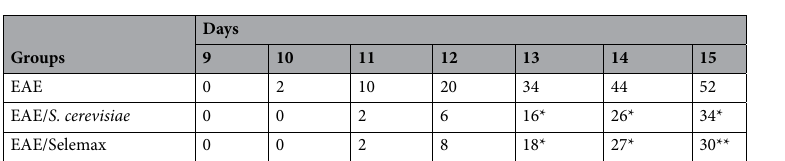
Figure 2. Effect of S. cerevisiae and Selemax on EAE development. EAE and non-EAE mice received 14 oral doses of S. cerevisiae or Selemax every day. The percentage of weight variation was calculated based on the initial and last animal´s body weight ( a ). Disease prevalence ( b ) and clinical score ( c ) were assessed daily for 15 days. Four independent experiments were combined, n = 6–8 in non-EAE groups and n = 16–21 mice in EAE groups. Inflammatory infiltration and demyelination were evaluated in hematoxylin/eosin (upper) and luxol fast blue (bottom) stained sections, respectively, obtained from control (non-EAE and non-supplemented mice), EAE, EAE/ S. cerevisiae and EAE/Selemax groups ( d ). Biochemical parameters as total selenium ( e ), urea ( f ), creatinine ( g ), alkaline phosphatase (ALK) ( h ), aspartate aminotransferase (AST) ( i ) and alanine aminotransferase (ALT) ( j ) were analyzed in serum samples. Two independent experiments were combined, n = 4–5 mice/group. Statistical analysis was performed by one-way ANOVA and subsequent Tukey’s test ( a , e ) or Holm-Sidak´s test ( f – j ), Log-rank (Mantel–Cox) test ( b ) and two-way ANOVA and subsequent Tukey’s test ( c ). All data were expressed as the mean ± SD and statistical differences were represented by * p < 0.05, *** p < 0.001 and **** p < 0.0001. The graphs were created using GraphPad Prism v.8.0.2 and image was modified with Adobe Photoshop v.22.0.0.